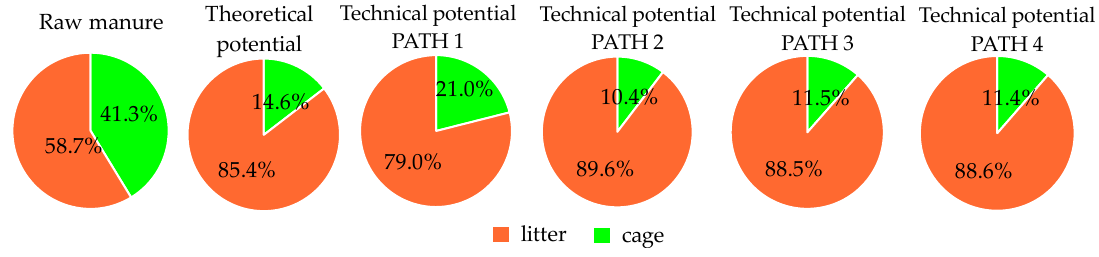
Figure 7. The contribution of particular types of manure in the determined energy potential.